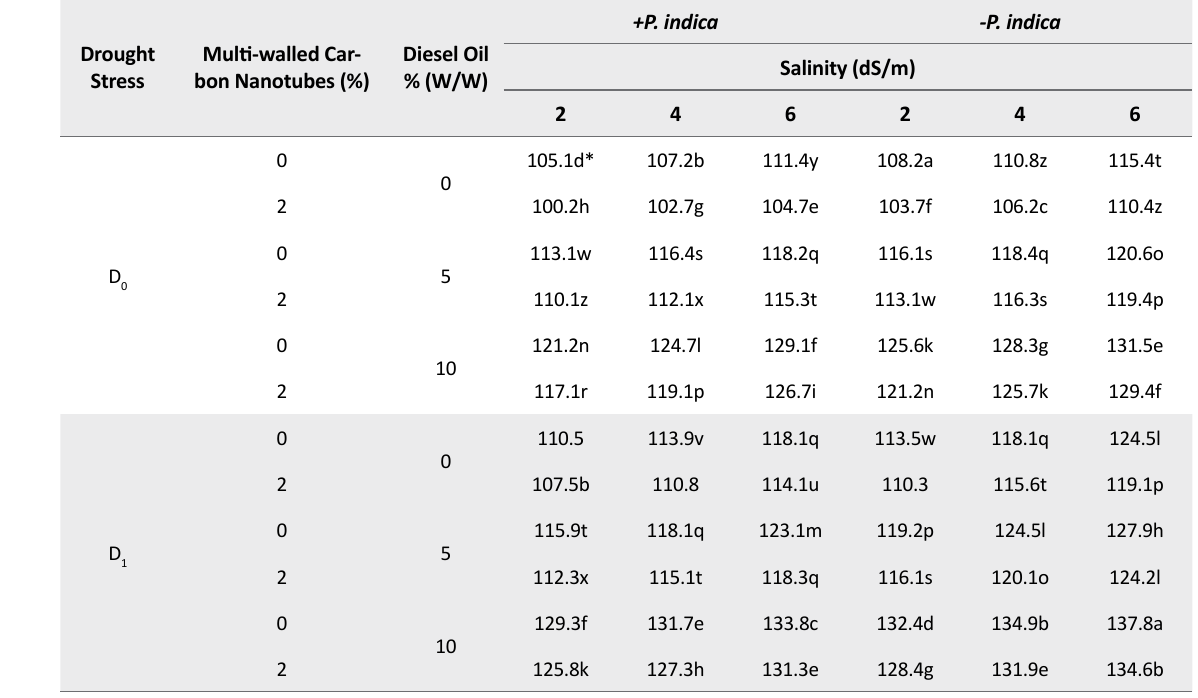
Drought Multi-walled Car- Stress bon Nanotubes